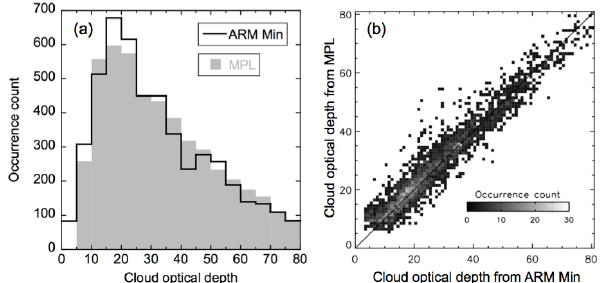
Figure 6. (a) Histograms of occurrence count and (b) a scatter plot for intercomparison of cloud optical depths retrieved from solar background signals received by micropulse lidar (MPL) and those from the ARM Min product. Colours represent the number of oc- currence count, and the black solid line represent the 1:1